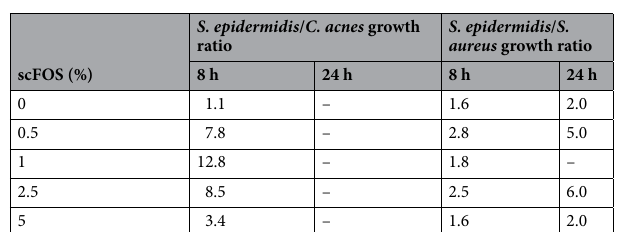
Table 2. Competition of bacterial strains for scFOS. Spread plate colony count of S. epidermidis and C. acnes competition, as well as S. epidermidis and S. aureus competition for scFOS at different concentrations in minimal medium, expressed as fold-change compared to the initial bacterial load. Results are expressed as mean ± SD. – value non calculated due to one 0 value.